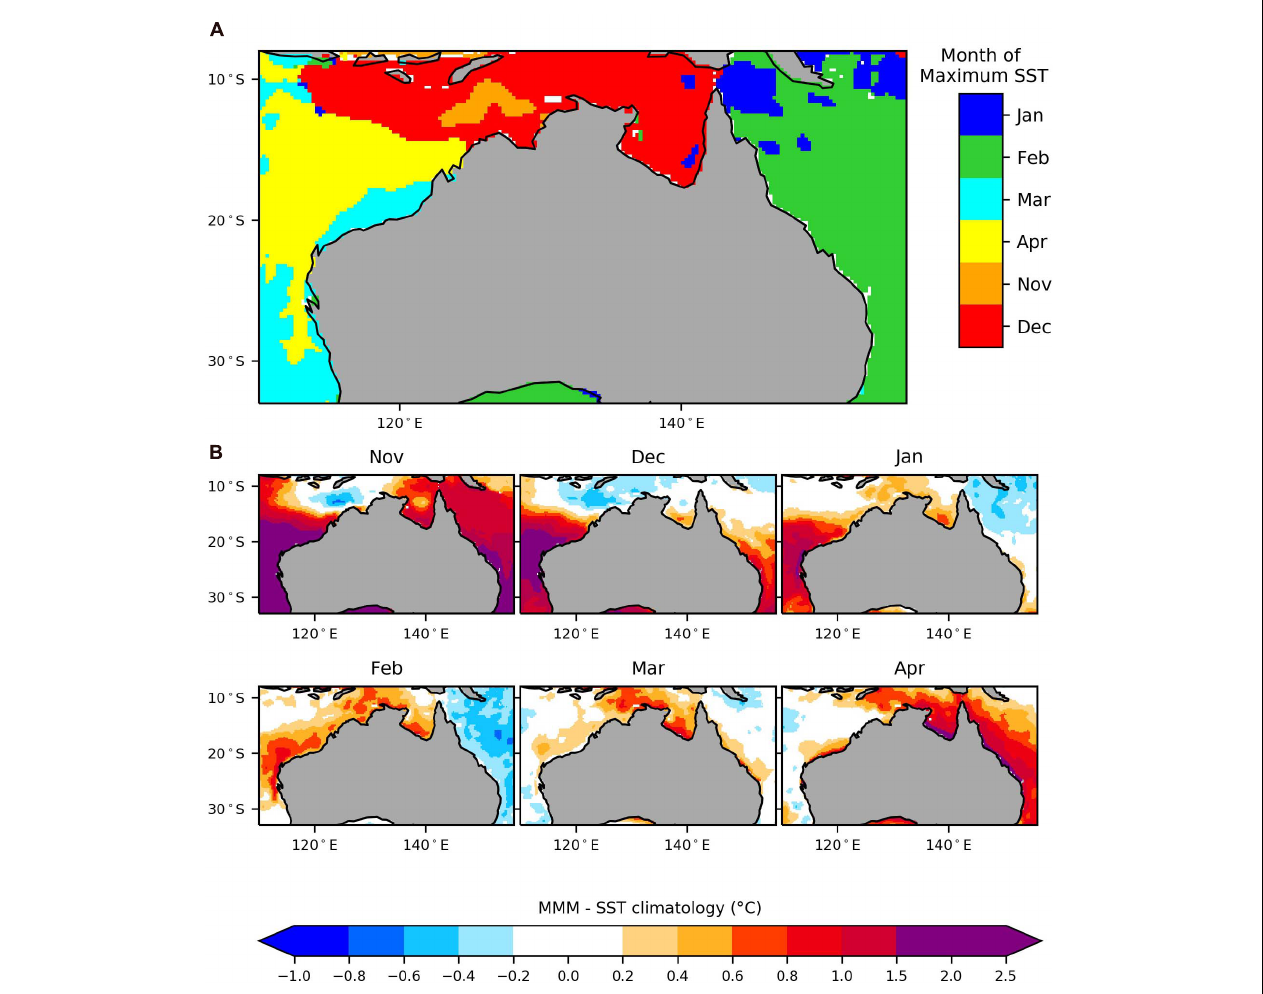
FIGURE 2 | (A) The warmest climatological month for the period 1990–2012 around Australia, based on Reynolds OISSTv2.0 data. (B) Maximum monthly mean (MMM) minus observed OISSTv2.0 monthly SST climatologies for November to April 1990–2012. Negative values indicate where the MMM is cooler than the observed monthly SST climatology, due to detrending of the MMM to November 1988 (see section “Materials and